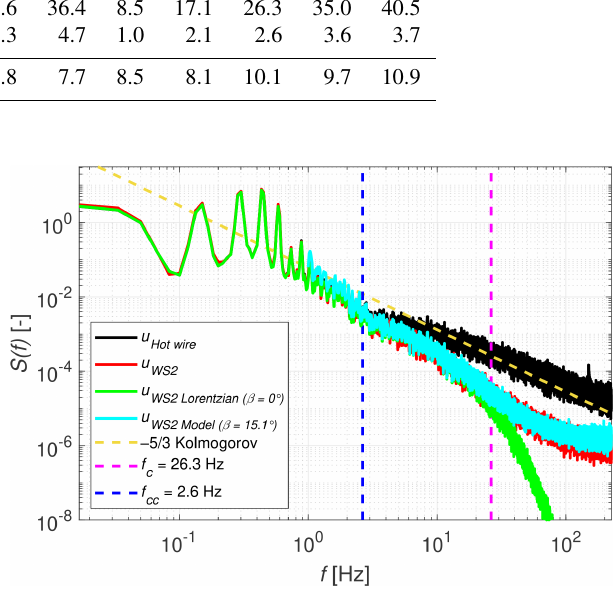
Figure 24. Spectrum of WindScanner 2 (measurements and model) for a coefficient of variation of 12.9% (Case